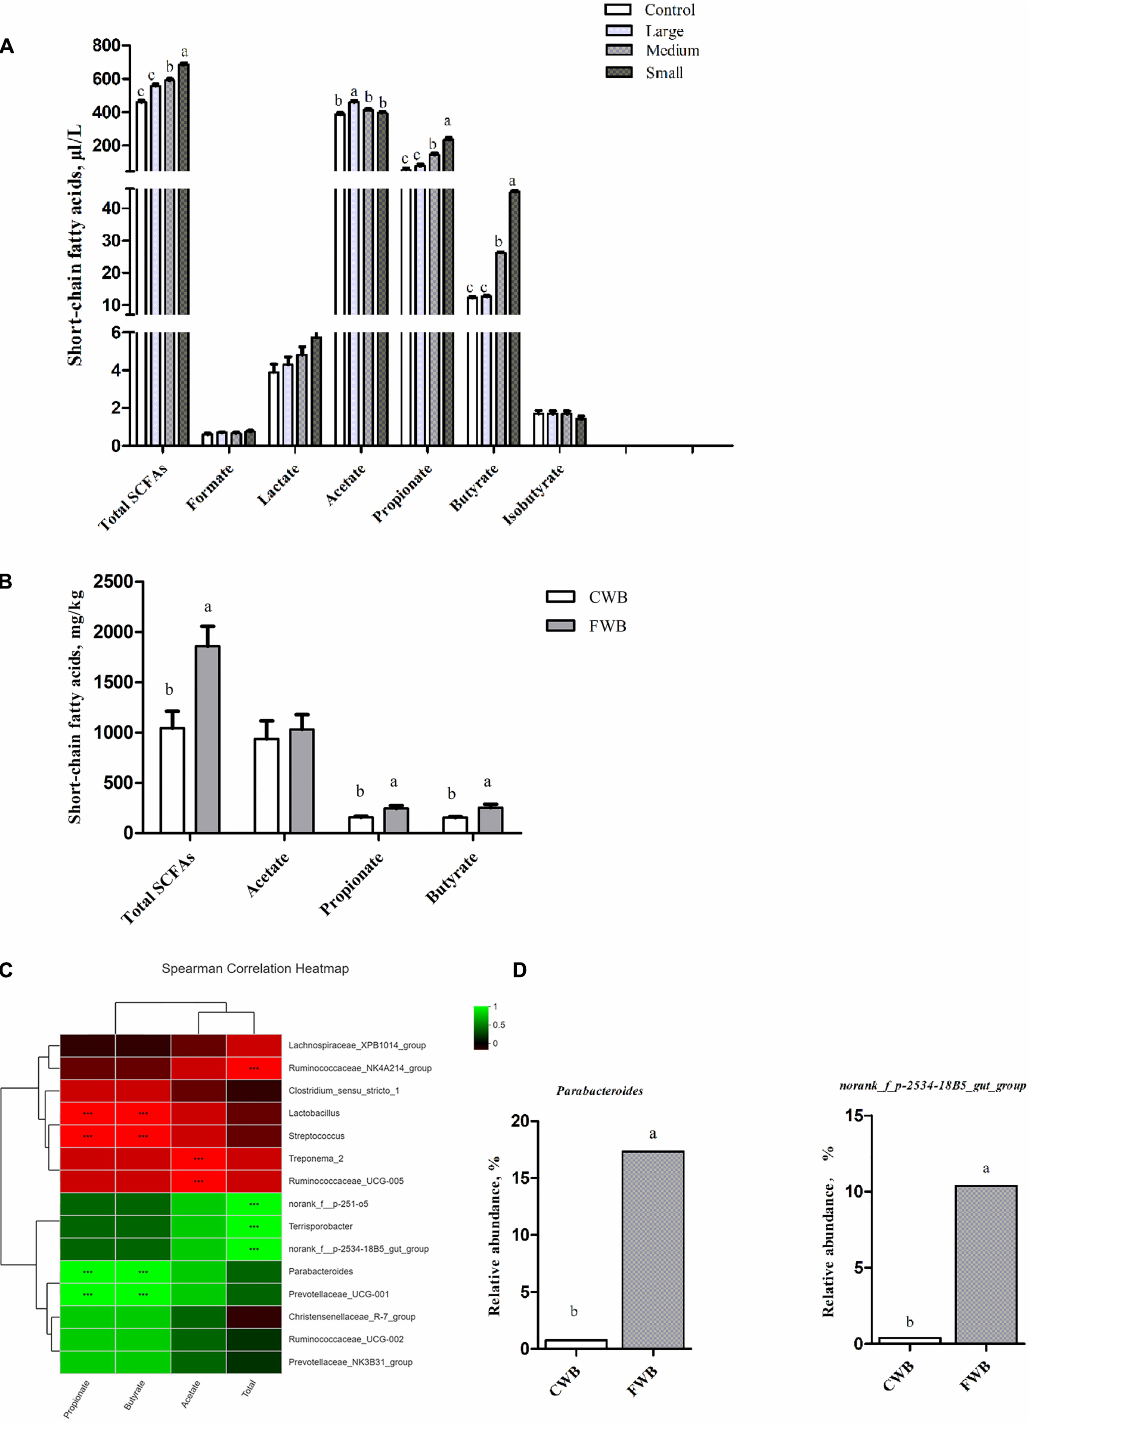
Frontiers in Microbiology |